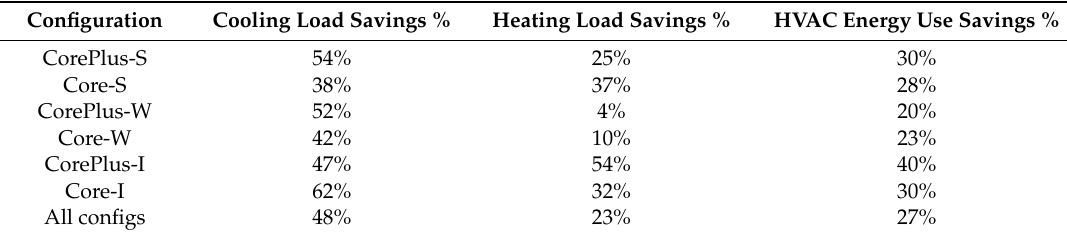
Table 5. Thermal load and HVAC energy savings for each configuration.